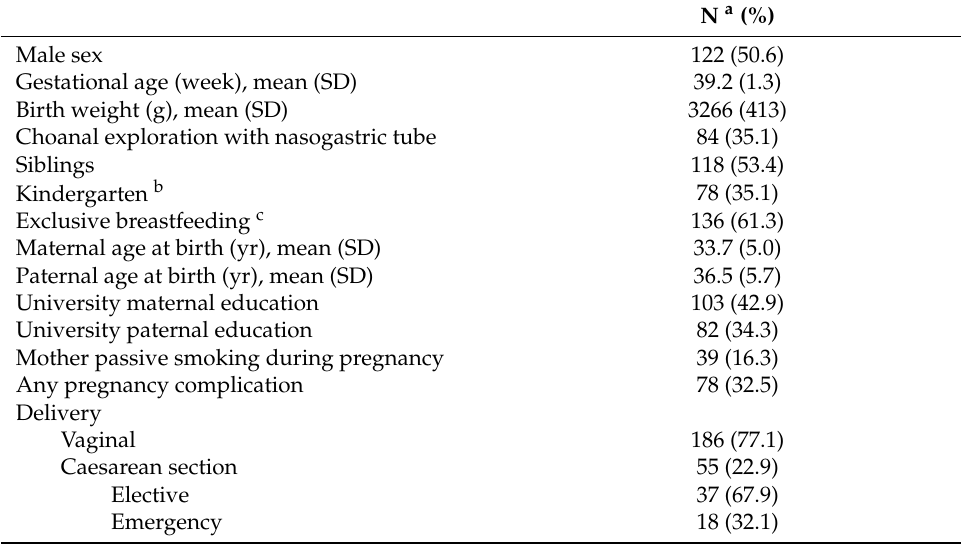
Table 1. Characteristics of 241 newborns included in the study and their